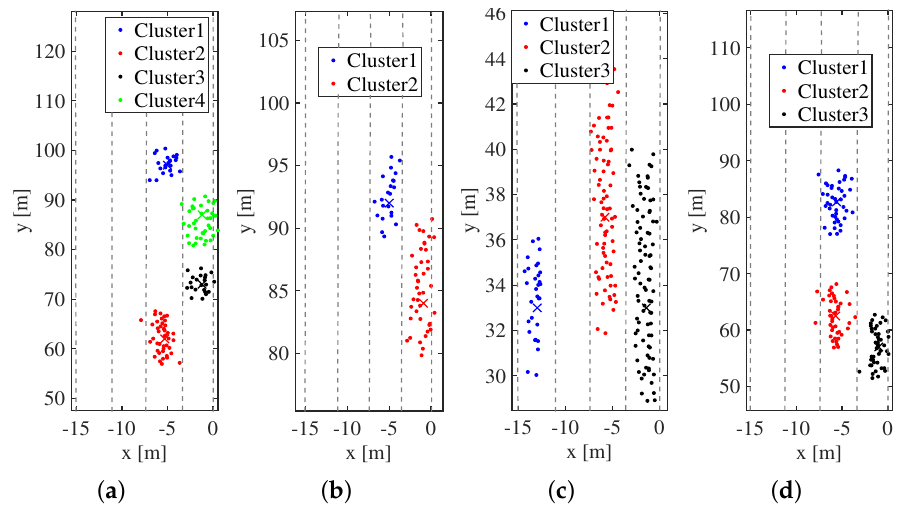
Figure 18. The clustering results of each scene: ( a ) Scene4; ( b ) Scene5; ( c ) Scene6; and ( d )